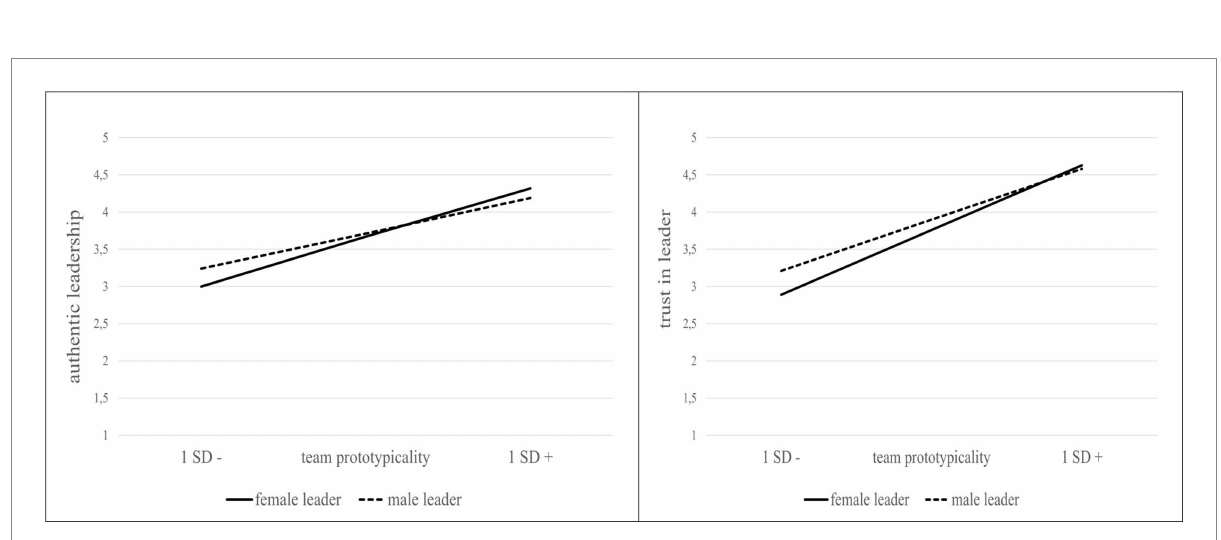
FIGURE 6 Study 2—Interaction between leader gender*team prototypicality predicting authentic leadership (left) and trust in leader (right).